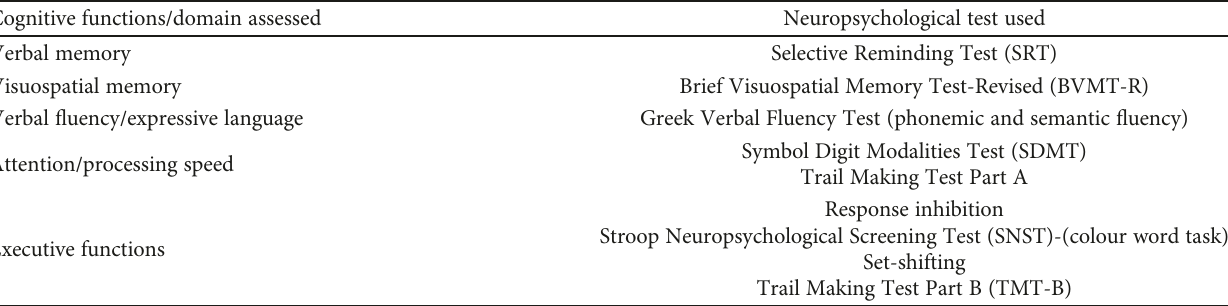
Table 2: Comprehensive neuropsychological battery that was administered and arranged by cognitive function/domain assessed. Cognitive functions/domain